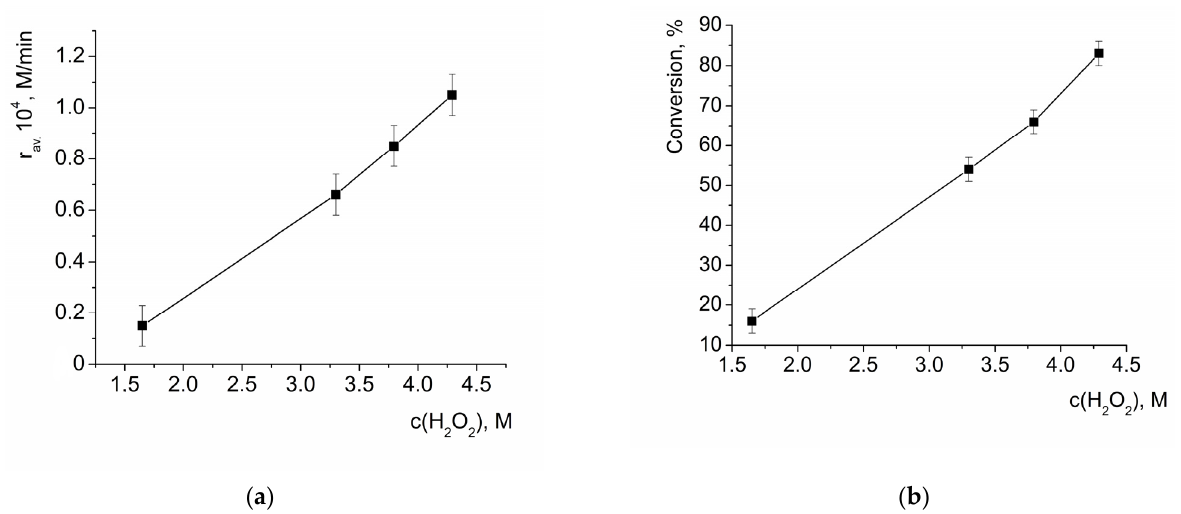
Figure 5. Dependency of the average initial rate of benzoin oxidation by H 2 O 2 in the presence of HKUST-1 ( a ) and conversion of benzoin after 3 h of reaction ( b ) on the initial concentration of H 2 O 2 . c(benzoin) = 0.033 M, c eff .(HKUST-1) = 0.001